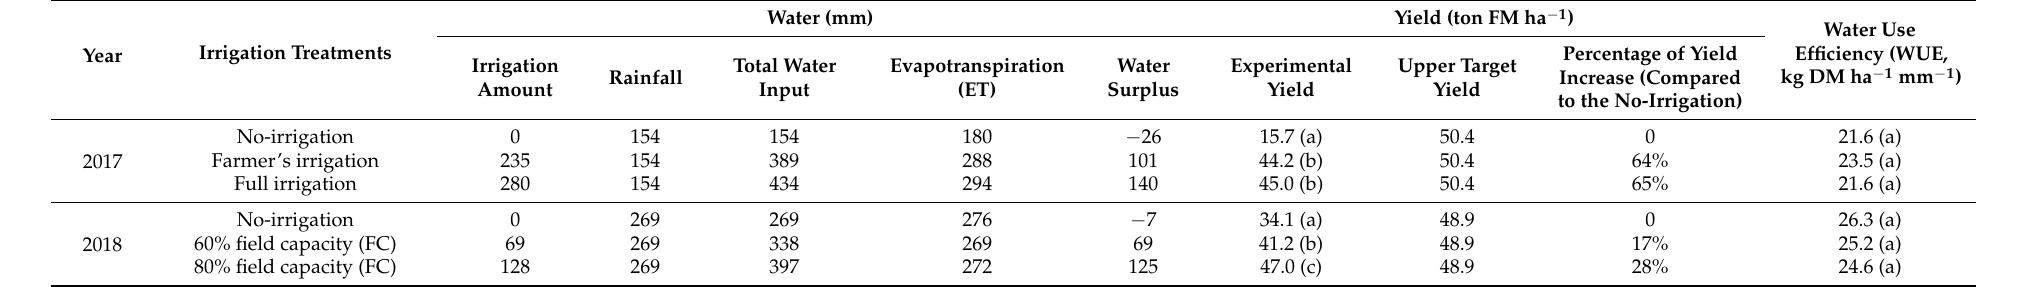
Table 4. The water management (input, output, water surplus), yield (experimental yield and upper target yield (80% of the potential yield)) and water use efficiency (WUE) of the 2017 and 2018 irrigation experiments. For the experimental yield and WUE in each year, no overlap of letters between different irrigation treatments refers to a statistically significant difference ( p <